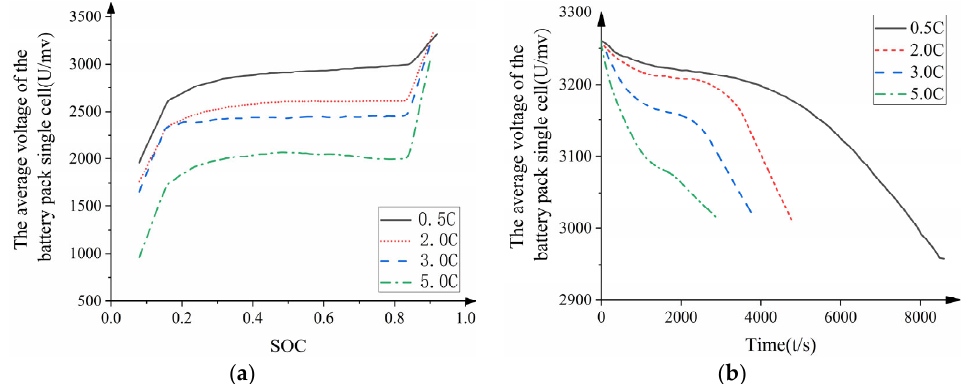
Figure 4. ( a ) The relationship between SOC and the terminal voltage of LiFePO4 battery single cells at different discharge rates. ( b ) The relationship between time and the terminal voltage of LiFePO4 battery single cells at different discharge rates.